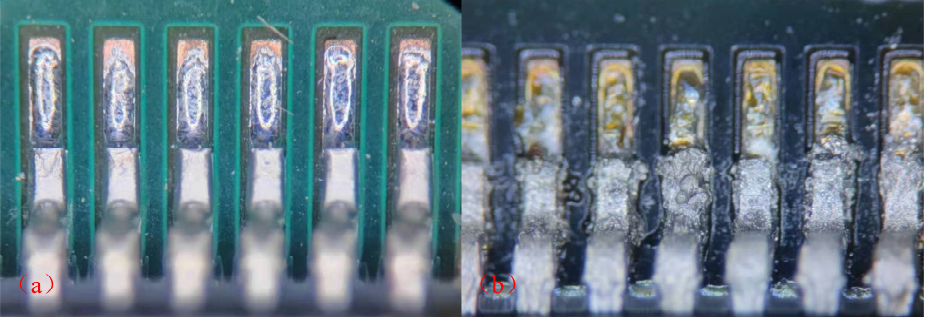
Figure 9. Enlarged view at D501 device pins ( a ) Before the electromigration test ( b ) After the electromigration test.